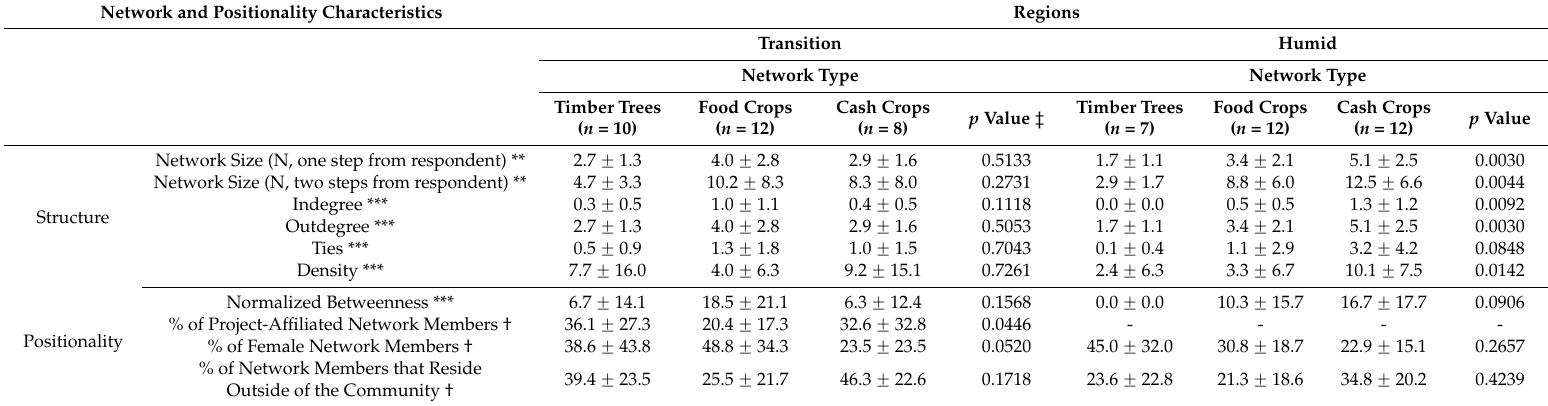
Table 3. Mean ( ˘ SE) network structure and farmer positionality values for crop-specific management in the Transition and Humid regions *. Network and Positionality